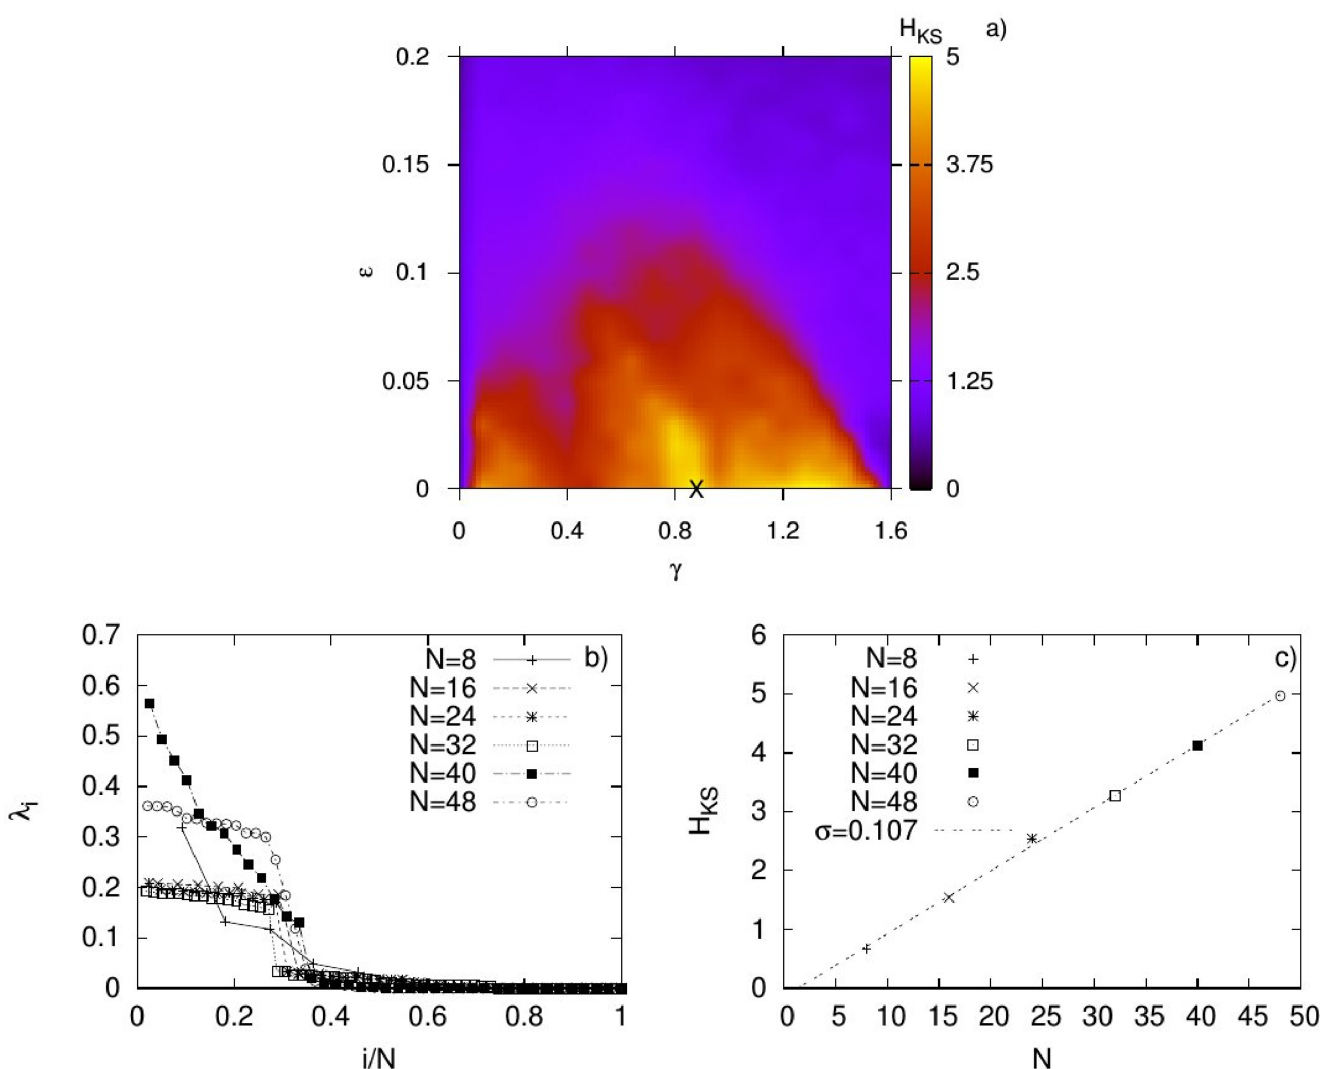
Fig 1. Extensivity in neural network evolution by maximising H KS . Panel a): An exampleof the parameter space of chemical γ and electrical coupling (cid:15) for N = 48 neuronsarrangedin two equally-sized small-world layers. The X point corresponds to the couplingpair for which H KS is maximal in the parameter space. Panel b): Plot of the Lyapunov spectra for different network sizes N and Panel c): The linear relationbetween H KS and network size N , where σ is the slope of the linear fitting to the data.